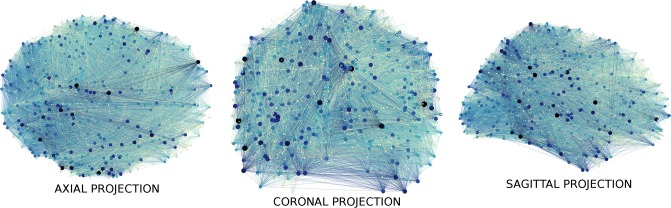
Network visualization.A visualization of a healthy, control functional connectivity network. Node size and darkness indicate a higher degree. Shown here are coronal, axial, and sagittal projections of the network onto a two-dimensional plane. Image made using Gephi [56] https://gephi.org/.